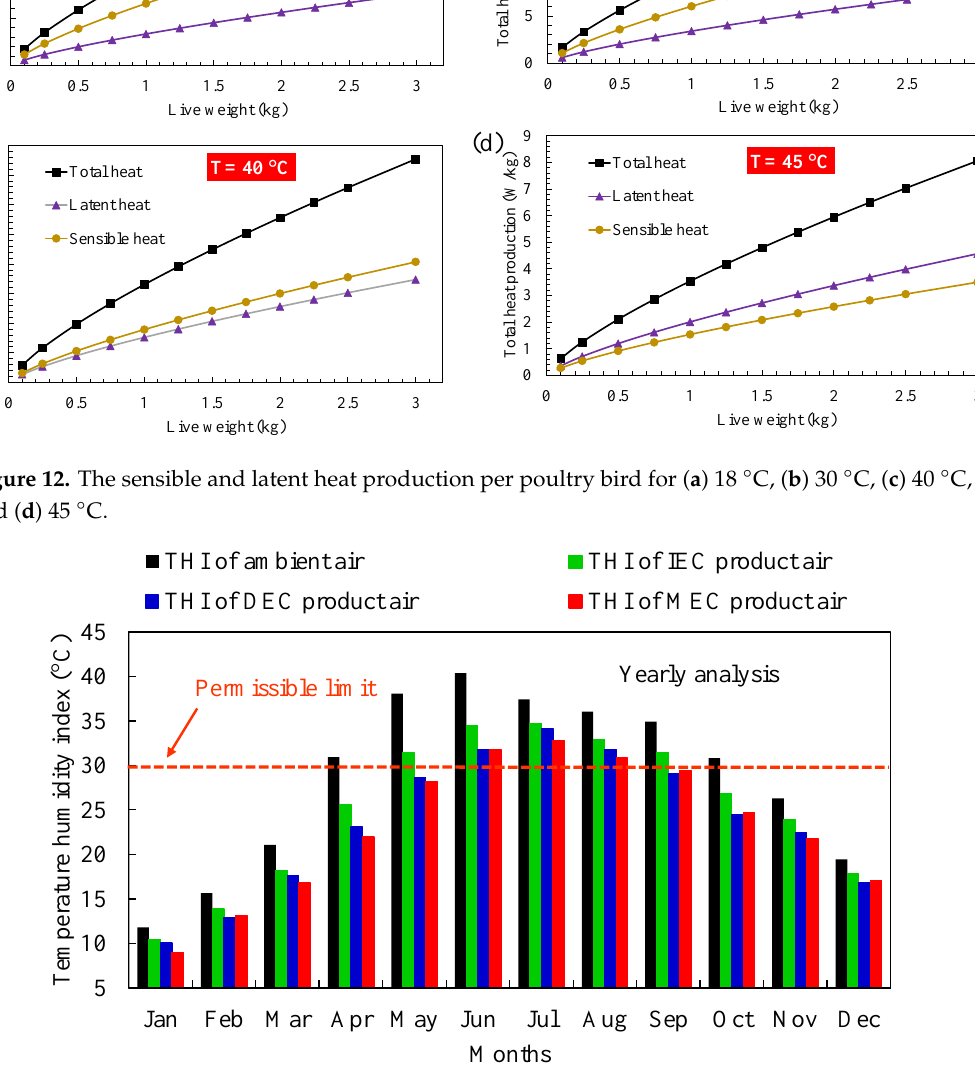
Figure 13. Annual profile of THI resulting from the EC systems for climatic conditions of Multan. The red dotted line shows the optimum level of THI i.e., 30.